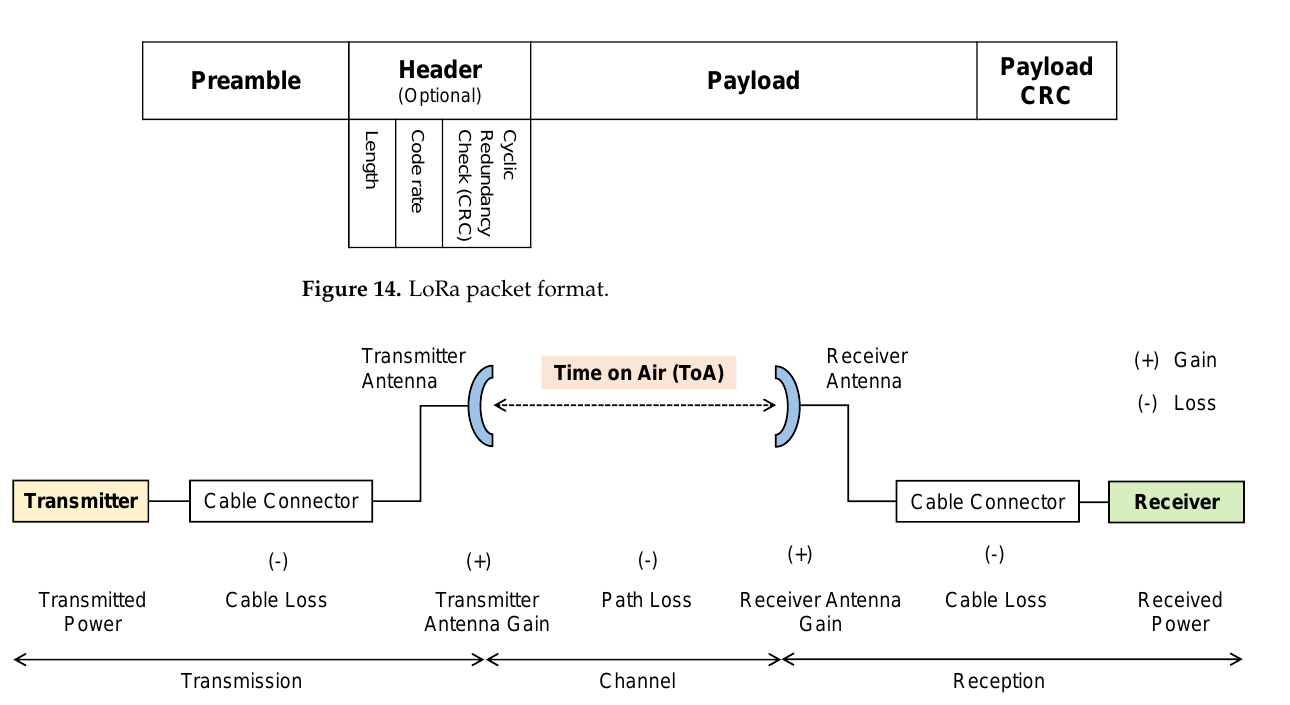
Figure 15. ToA representation in a transmitter – receiver communication system.